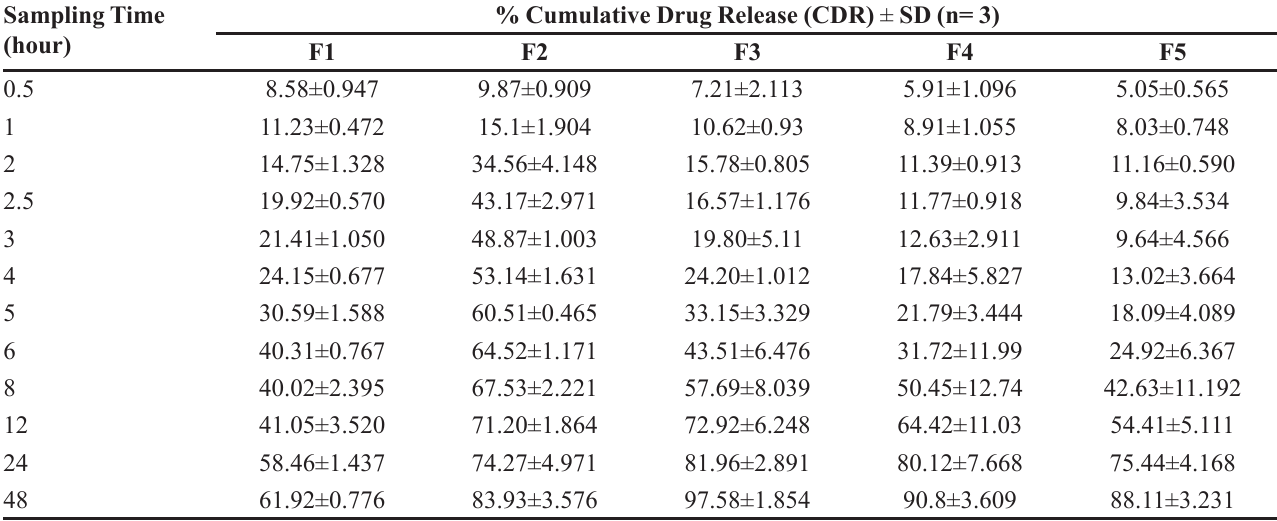
TABLE III - In vitro release profile of irbesartan from the freeze dried SLNs (F1 to F5) Sampling Time